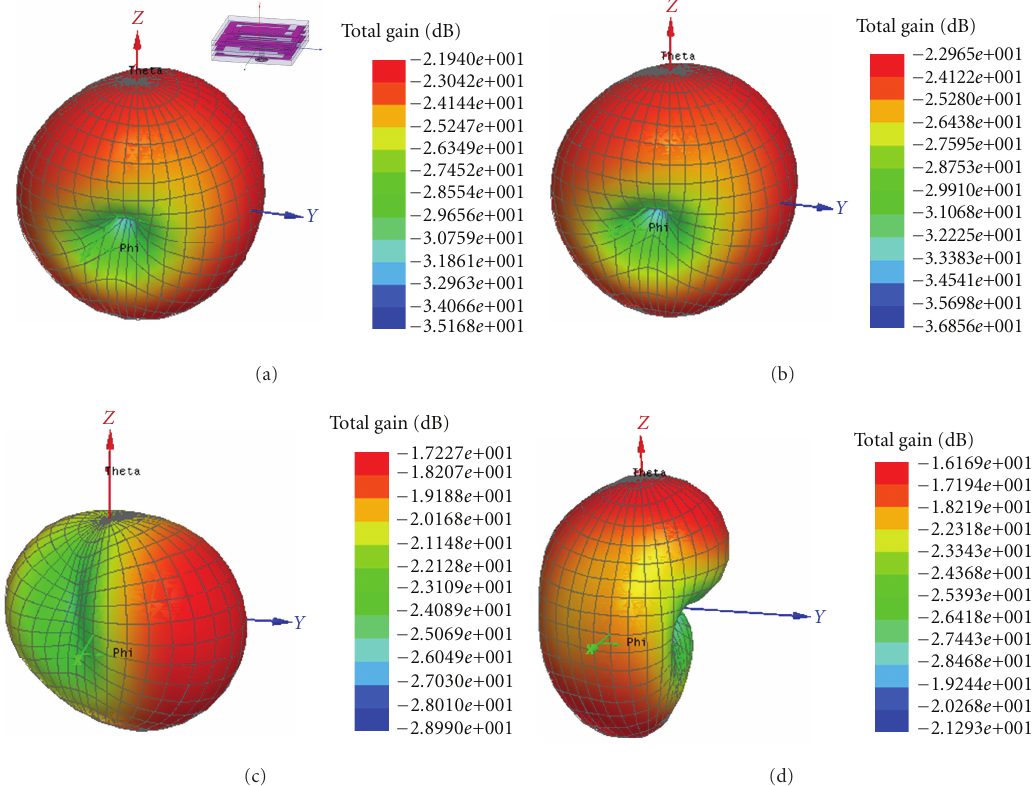
Figure 12: Simulated three-dimensional antenna radiation patterns (delivered power = 1 W), (a) 401 MHz, (b) 433MHz, (c) 1.427 GHz, and (d)